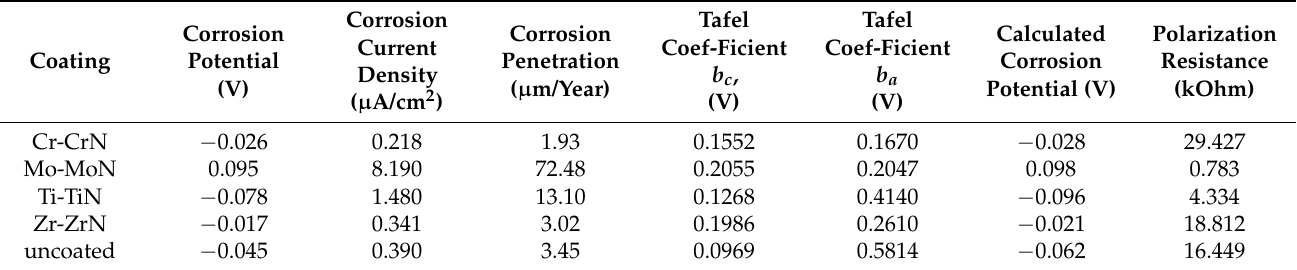
Table 4. Results of mathematical modeling of the corrosion process on the samples made of Ti-6Al- 4V alloy with di ff erent coatings in the 3 wt.% aqueous solution of NaCl at the temperature of 25 °C, by the method of iterations based on experimental data arrays. Table 5. Results of mathematical modeling of the corrosion process on the samples of Ti-6Al-4V alloy with different coatings in the 3 wt.% aqueous solution of NaCl at the temperature of 25 ◦ C, by the method of Tafel extrapolation of the anodic and cathodic polarization